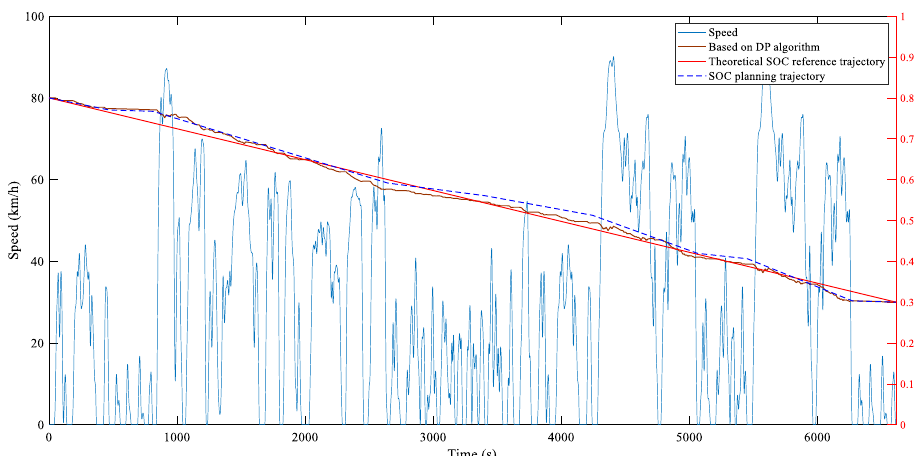
Figure 11. SOC planning trajectory comparison with SOC trajectory based on DP algorithm.